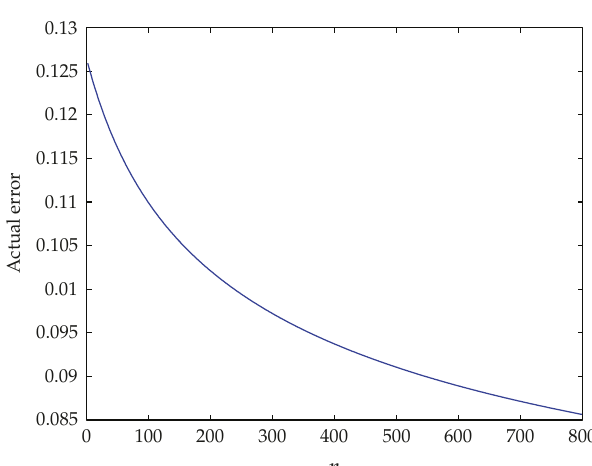
Figure 3: T he actual error, Δ n , for r n (cid:4) 1 / (cid:5) n (cid:2) log n (cid:3) 1 / 2 (cid:2) log log n (cid:3)(cid:6) and (cid:2) x,y (cid:3) (cid:4) (cid:2) 1 , 1 (cid:3) .